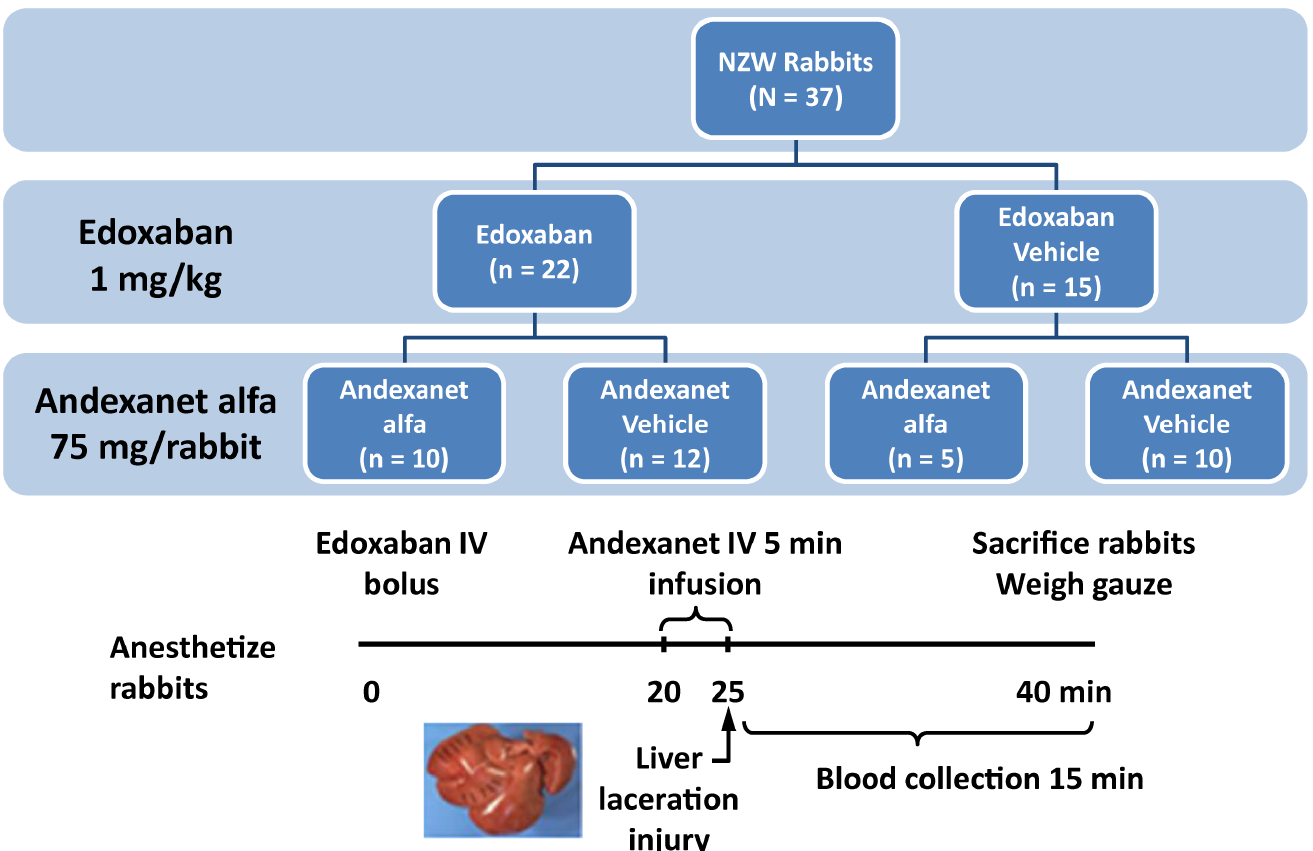
Fig 1. Design of rabbit liver laceration model of acute hemorrhage